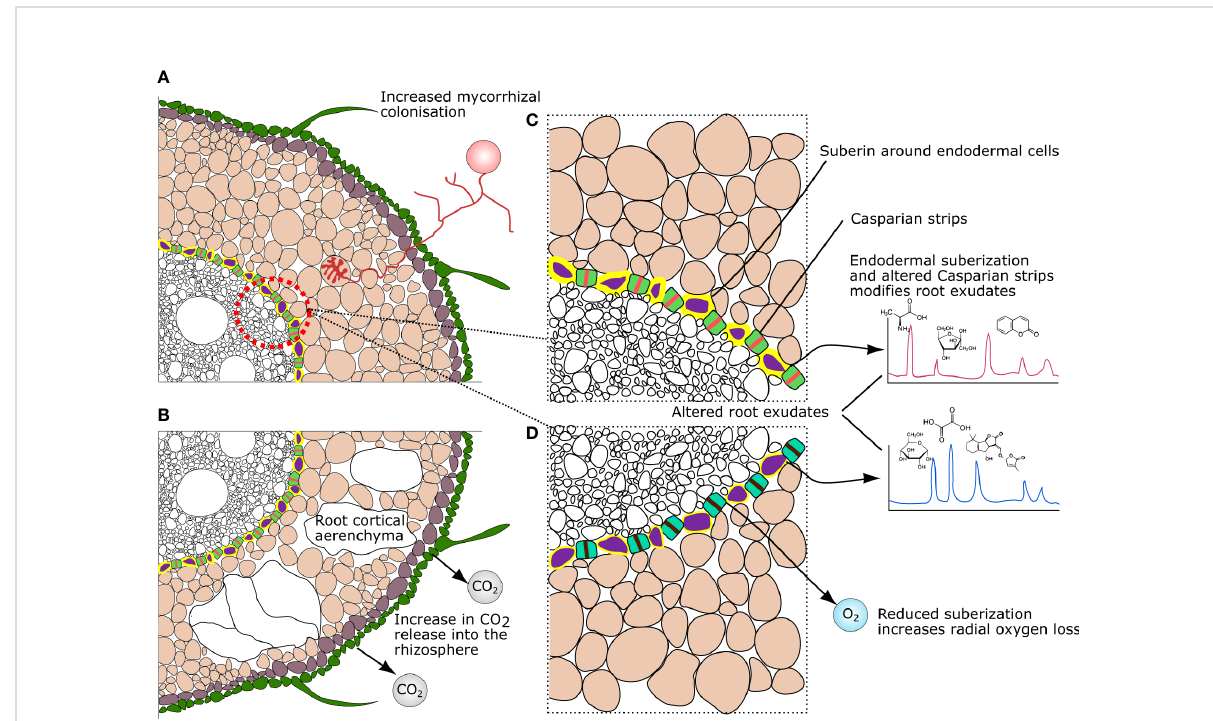
FIGURE 2 Variation in root anatomical traits and their in fl uences on chemical gradients modulating microbial microhabitats in the rhizosphere: (A, B) variation in root cortical aerenchyma; and (C, D) Suberin and Casparian strip modi fi